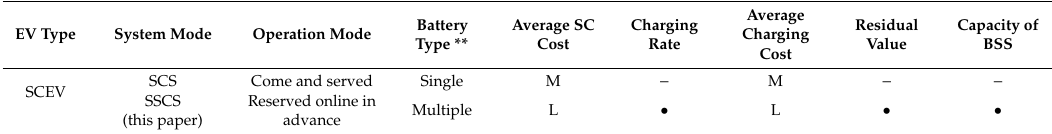
Table 2. Comparisons between the SCS mode and SSCS mode